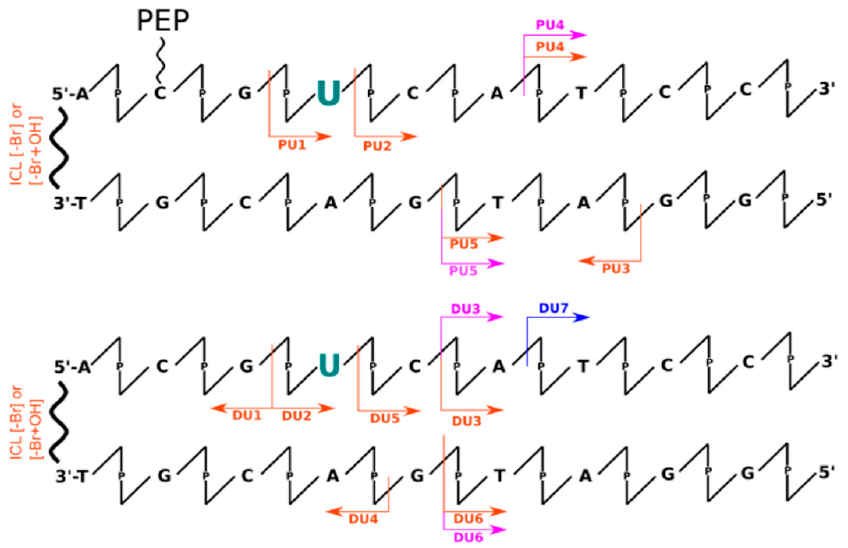
Figure 4. Schematic representation of all identified oligonucleotides’ fragments by means of LC-MS for BrdU labeled systems (upper with peptide conjugate, lower without peptide conjugation). The scheme represents only part of the dsDNA structure. The arrows represent the respective fragments identified for X-ray radiation experiments (blue), UV irradiation by 320 nm photons (pink), and 280 nm photons (orange). Modified nucleobase was pointed in green. Below the arrows the names of identified fragments are listed starting with “P” stands for system with peptide conjugation, starting with “D” without peptide conjugation. Additionally, the interstrands cross- links (ICL) were observed. For possible mechanisms, please see Figures S7–S11.